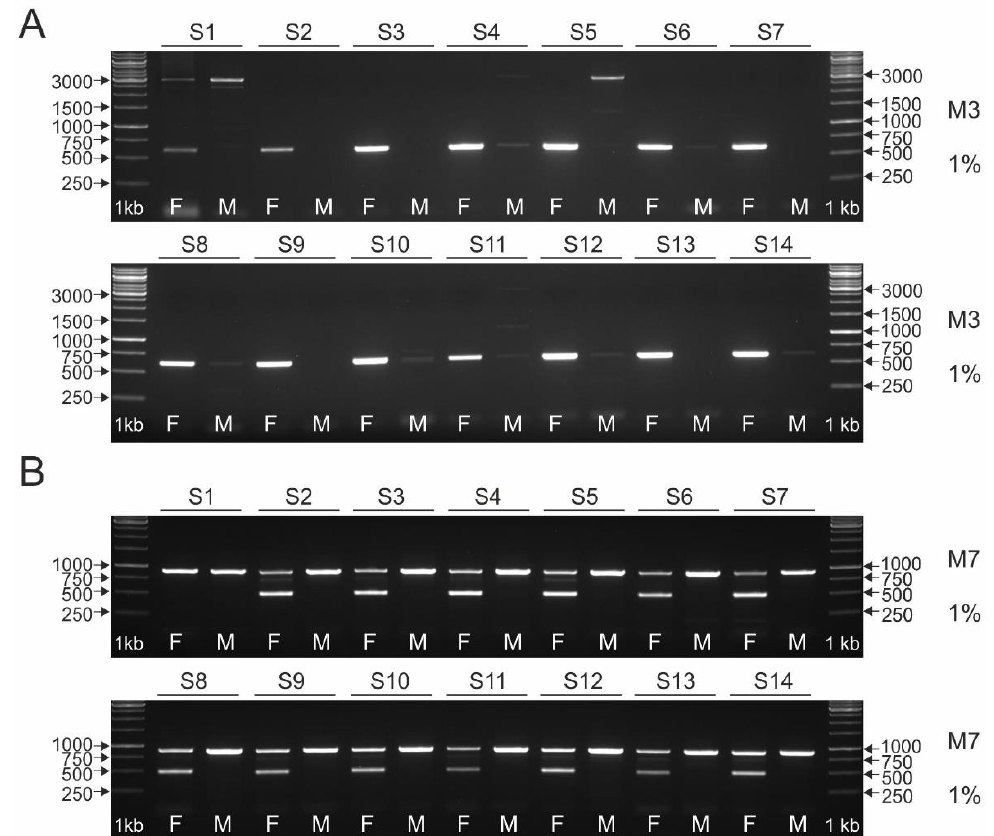
Figure 5. Patterns of the PCR products representing M3 ( A ) and M7 ( B ) markers obtained for male (M) and female (F) individuals of fourteen turaco species (S1–S14, see Table 1). The amplicons were resolved in 1% agarose gel. Lane 1 kb—GeneRuler 1 kb DNA Ladder (Thermo Scientific).